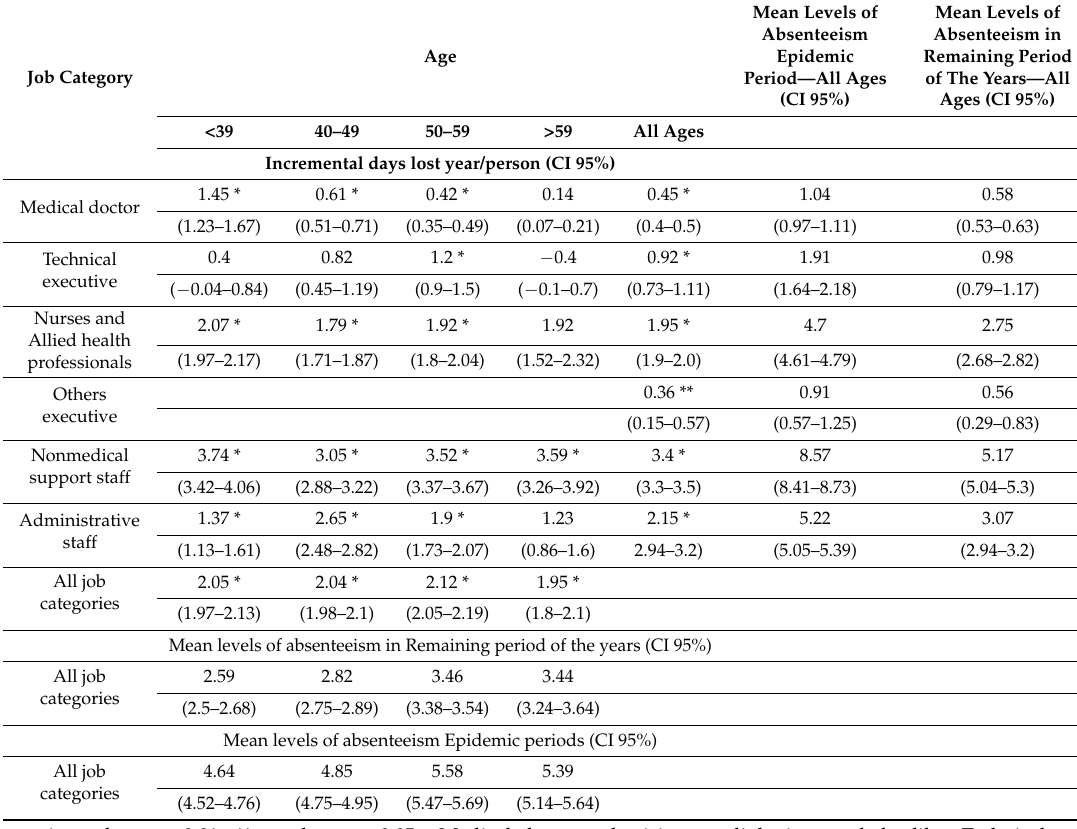
Table 3. Excess of absenteeism during epidemic periods for age ranges and job categories (working days lost per person per